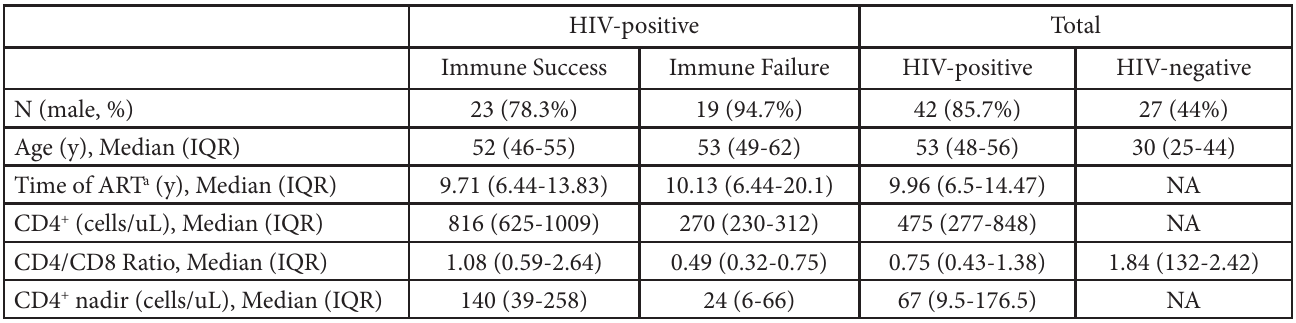
Table 1. Participant